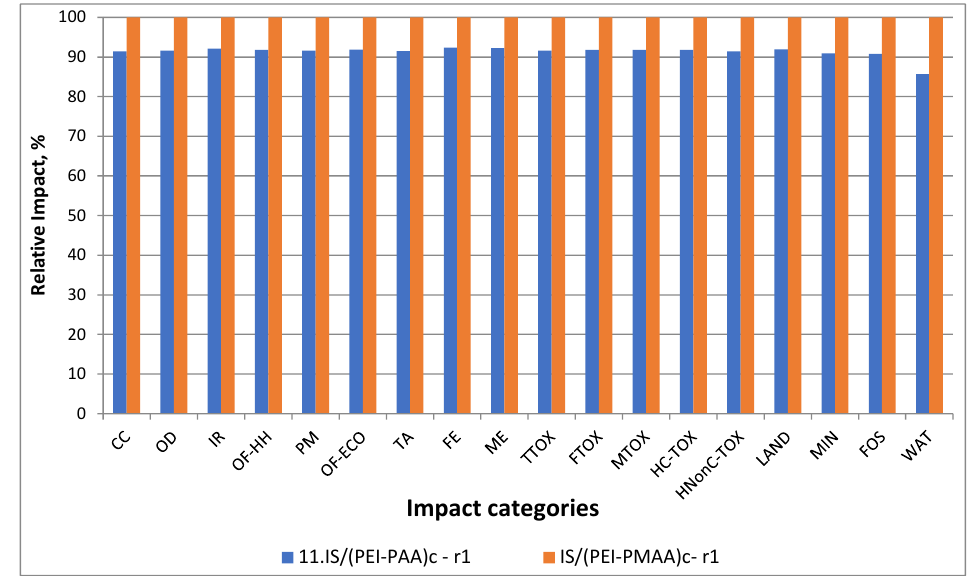
Figure 7. Scenario 3 vs. the reference case comparison of environmental impacts.